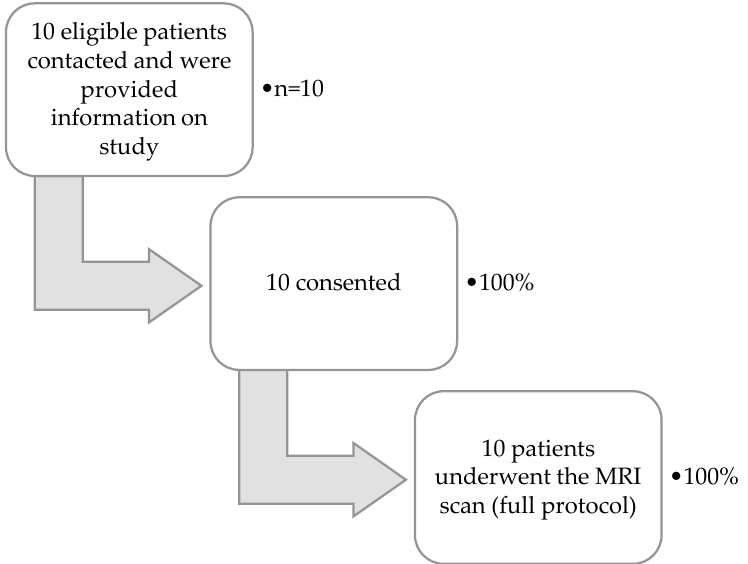
Figure 2. Magnetic resonance imaging (MRI) cohort flow chart.